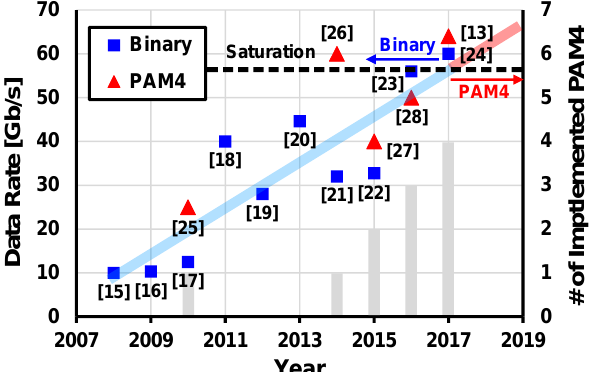
Figure 4. Trends of copper-based electrical links from recent 10-year ISSCC papers.